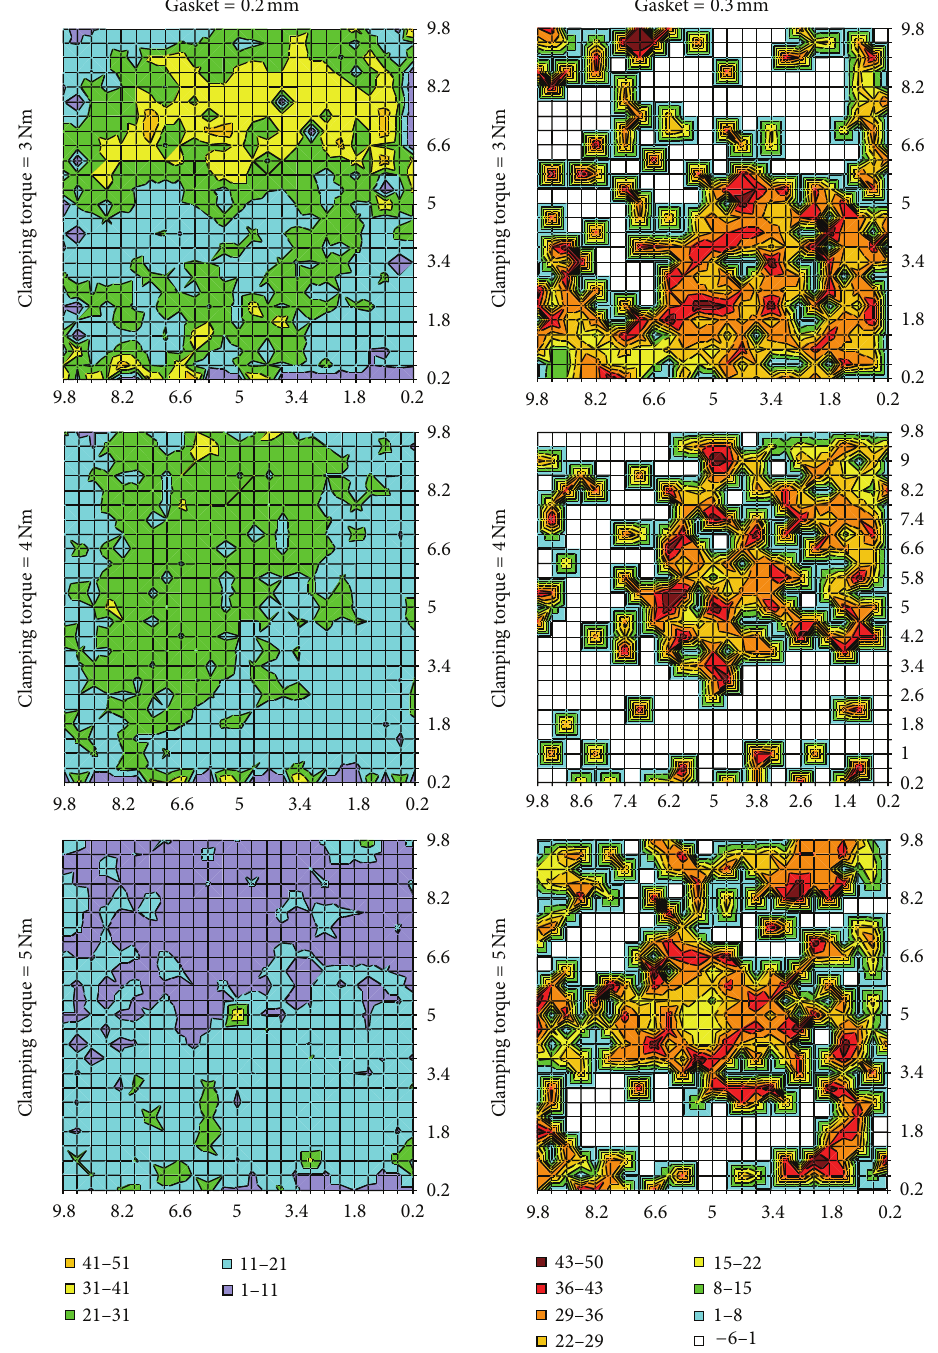
Figure 10: Contact resistance distribution (m Ω cm 2 ) between GDL and BPP for different configurations.